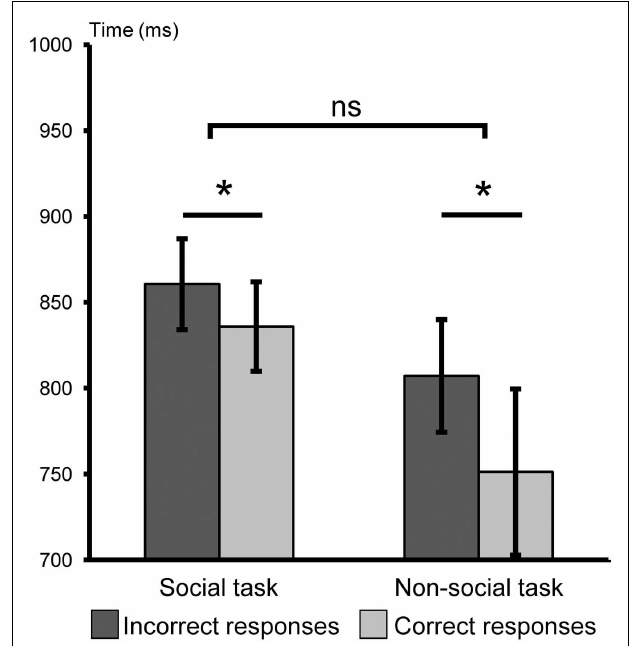
FIGURE 5 | Experiment 2, mean reaction times of correct and incorrect responses in the post-association phase for social and non-social categorization tasks. In light gray, correct responses; in dark gray, incorrect responses; * p < 0.05; ns, non-significant. Error bars indicate standard error of the